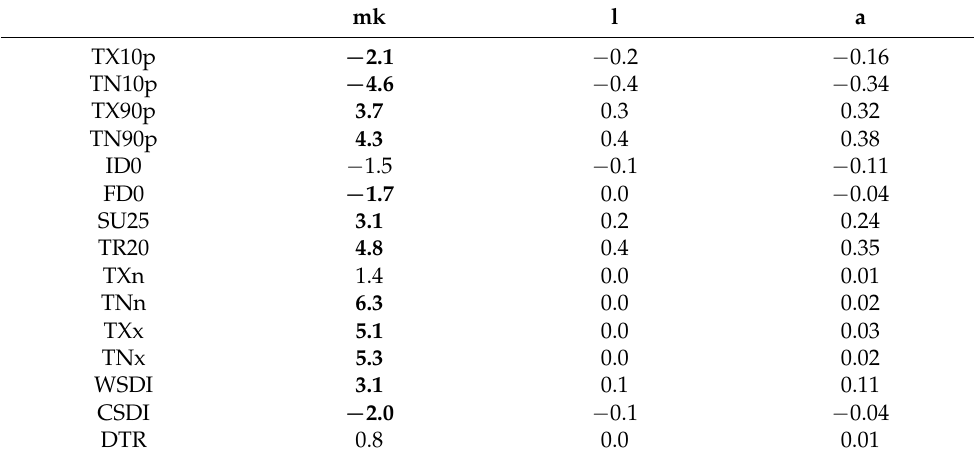
Table 3. Temporal trends of extreme temperature indicators in the Qingyi River basin.